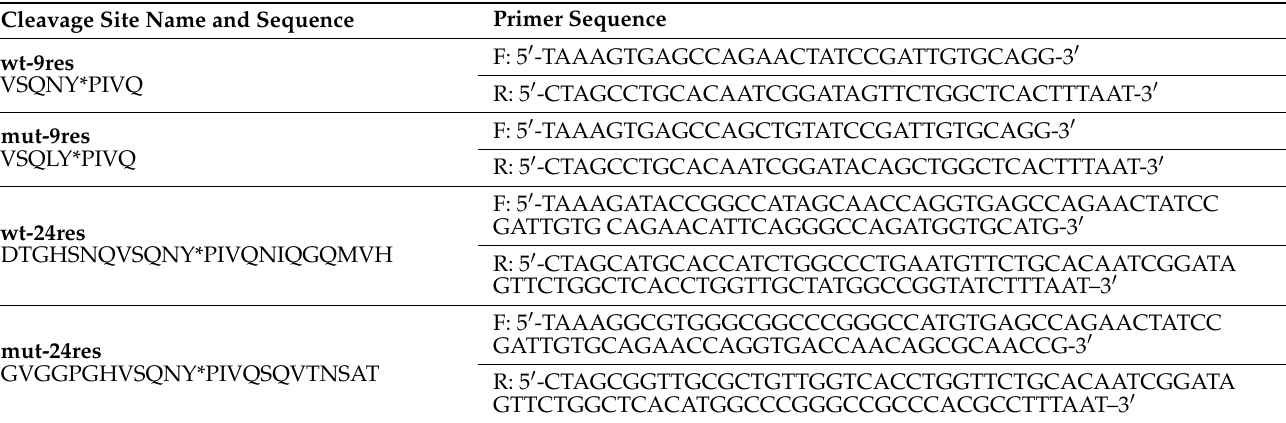
Table 1. The oligonucleotide primers coding for cleavage sites of HIV-1 PR. “F” and “R” indicate forward and reverse primers, respectively. Cleavage site sequences are also indicated, asterisks indicate cleavage position. The primer coding for the wt-9res cleavage site was described previously